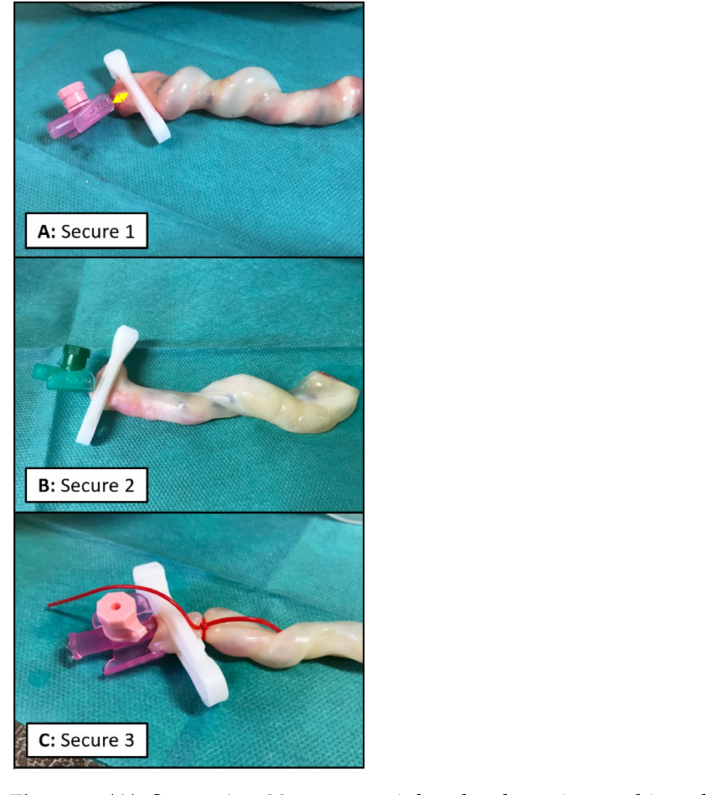
Figure 2. ( A ): Secure 1: a 20-gauge peripheral catheter inserted into the umbilical vein secured by a disposable umbilical clamp closed at the level of the transparent catheter. The yellow arrows indicate the distance between the colored plastic wings and the disposable umbilical clamp, which is longer in Secure 1 compared to Secure 2 and Secure 3. ( B ): Secure 2: an 18-gauge peripheral catheter inserted into the umbilical vein secured by a disposable umbilical clamp closed at the junction of the transparent catheter and the colored plastic wings. ( C ): Secure 3: a 20-gauge peripheral catheter inserted into the umbilical vein secured by a disposable umbilical clamp closed at the junction of the transparent catheter and the colored plastic wings, and by an additional umbilical tape placed around the umbilical cord at the level of the transparent